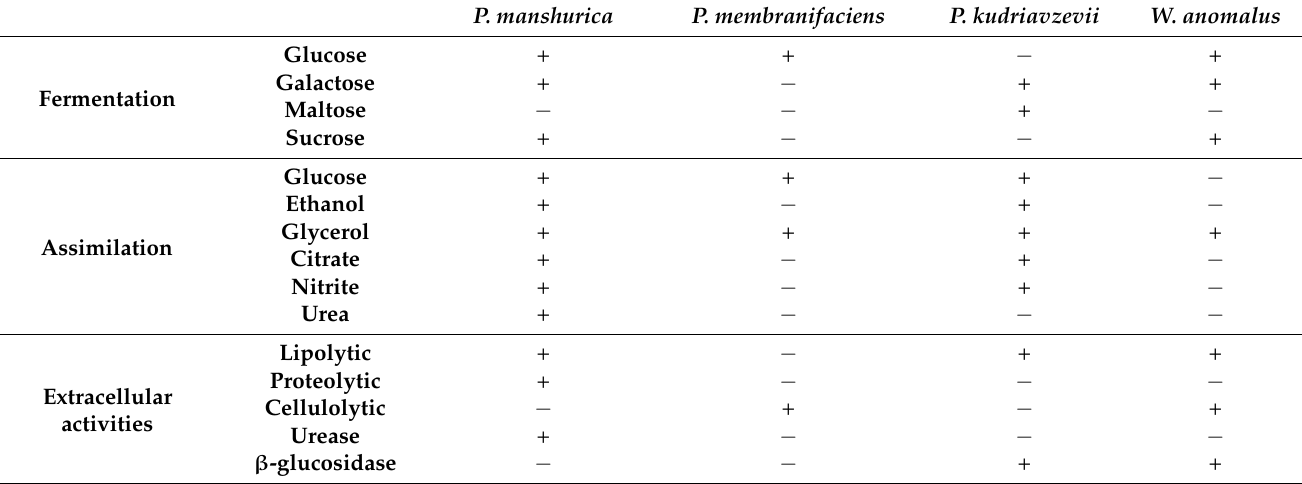
Table 1. Fermentation, assimilation and extracellular enzymatic activities of selected non- Saccharomyces yeasts. Values are expressed as (+) if strains showed the specific capability, and ( − ) if